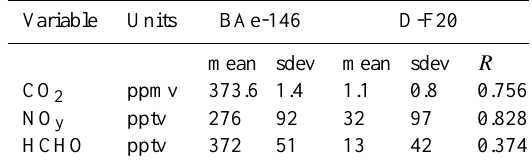
Table 5. Results from comparison flight legs between BAe-146 and D-F20 in formation. The mean and standard deviation of BAe- 146 measurements is shown. The difference between D-F20 and BAe-146 is summarised by its mean, standard deviation and rank correlation ( R ). A running median filter with a window width of 10s was applied to all data before putting on common